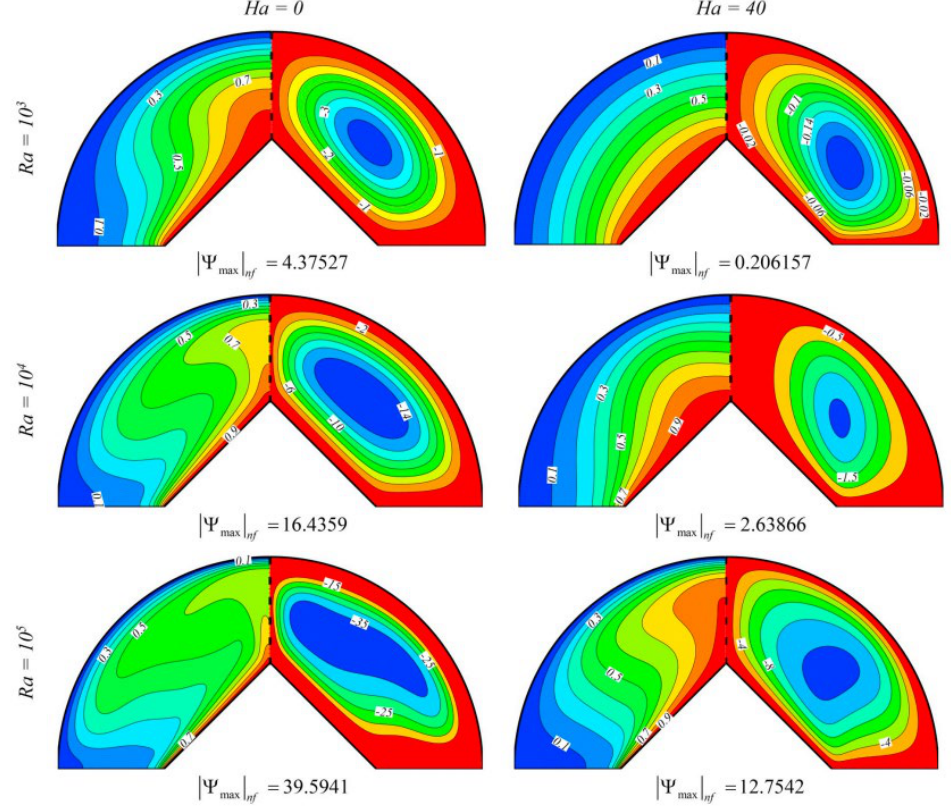
Figure 4. Effect of Ra and Ha on contours of streamlines ( right ) and isotherms ( left ) when ∅ = 2%, Hs = 2. Reprinted with permission from Ref. [18]. 2020, Elsevier.